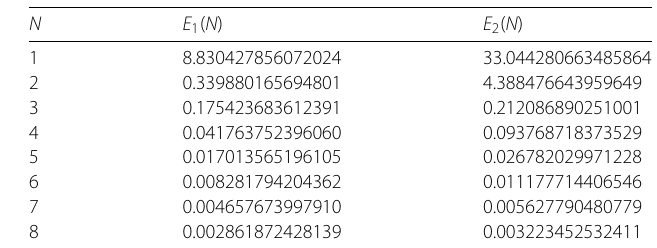
Table 4 The max error for Example 8.3 for α = 0.9, on [0,15]